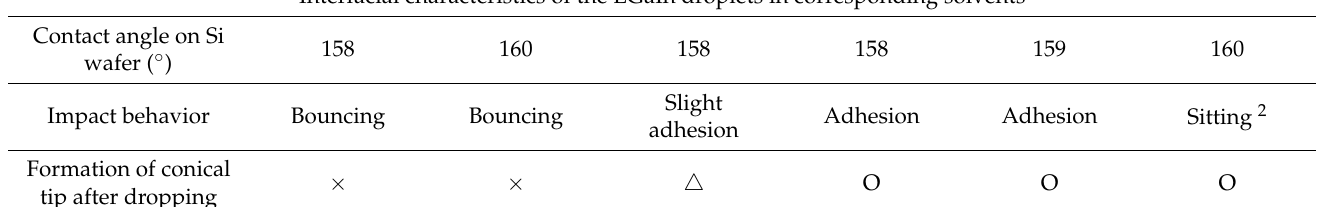
Figure 5. Interfacial behaviors depending on Kamlet–Taft parameters β and π * .